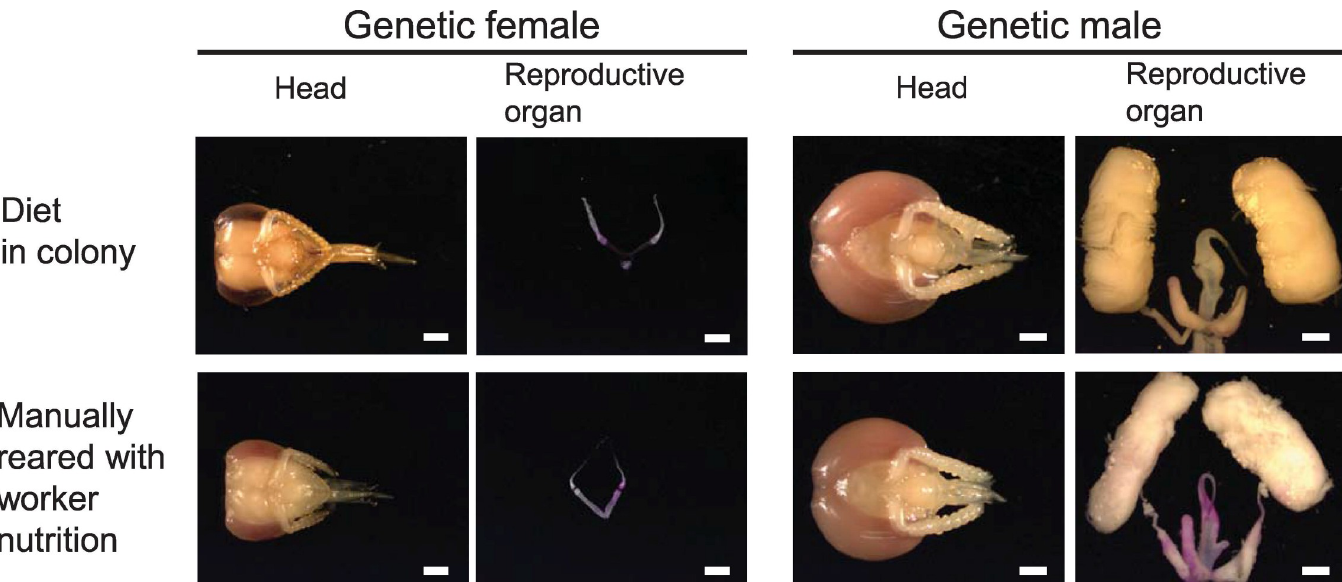
Fig 1. Reproductive organ and head phenotypes of females and males reared on worker nutrition in the laboratory and in the colony. Scale bar = 1 mm.